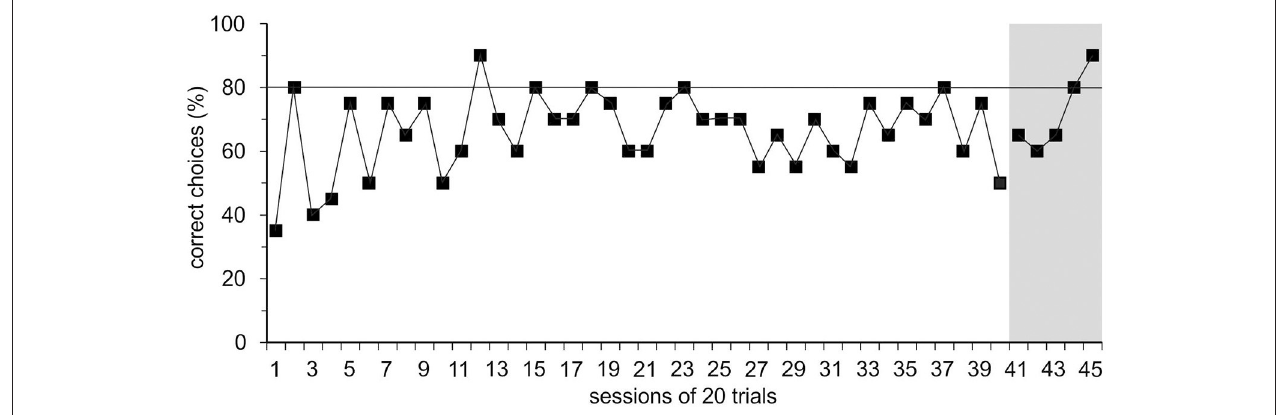
FIGURE 2 | Results of the spatial reversal learning experiment. Exemplary performance of experimental animal Ov1 as correct choices (in %) over time during the acquisition phase (R0) in which it was trained only with positive reinforcement but without incorrect-choice signal (ICS). Ov1 did not reach the learning criterion defined as a performance of ≥ 80% correct choices in two consecutive sessions (continuous line) in 40 sessions with 20 trials. After the introduction of the ICS indicating the incorrectness of the response in session 41, Ov1, however, reached the learning criterion after five